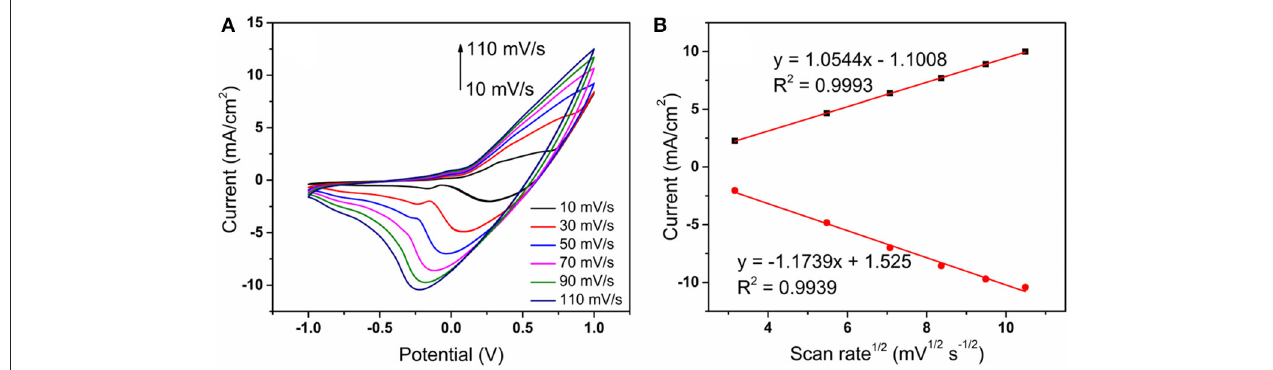
FIGURE 6 | (A) CVs of the CoNiCu electrodes in 0.1M NaOH + 0.3mM glucose at different scanning rates (10–110mV s − 1 ); (B) redox peak currents as a function of the square root of the scan rate.